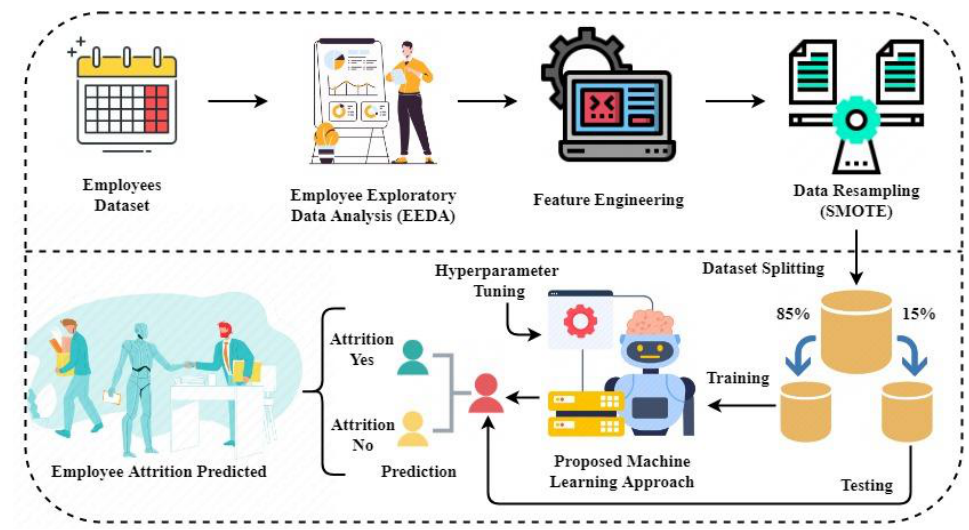
Figure 1. The methodological analysis of our proposed research study for employee attrition predic- tion.